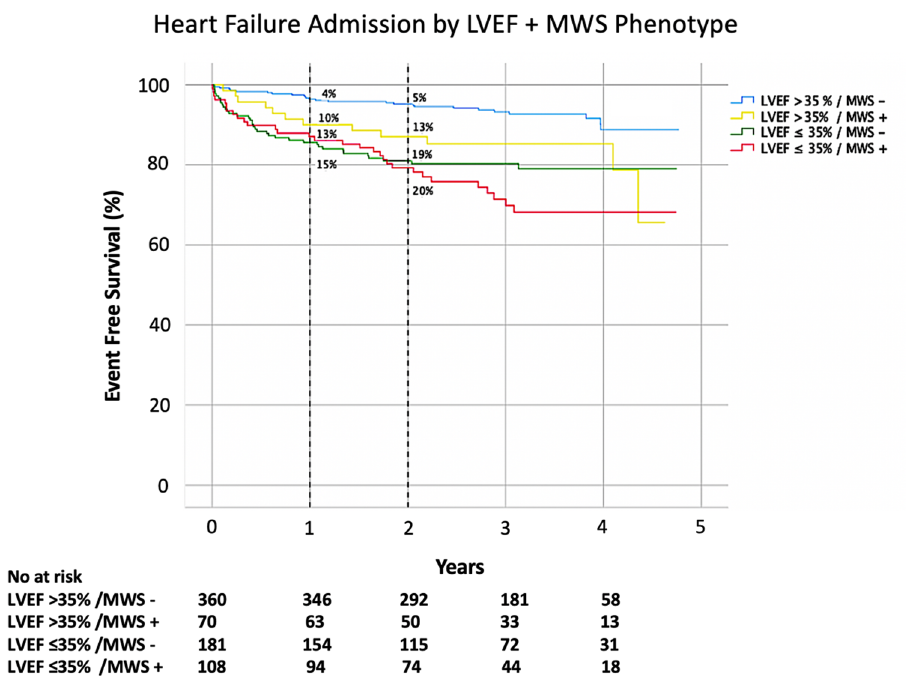
Figure 3. Kaplan–Meier event free survival curve for the primary outcome of heart failure hospitalization stratified by the combined presence or absence of mid-wall striae (MWS) fibrosis and LVEF ≤ 35%.